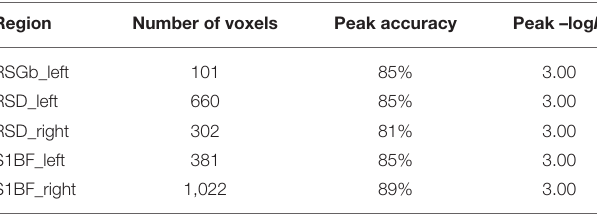
TABLE 2 | The top regions that contributed to kindling-control classification (SVM) based on GMV maps. Region Number of voxels Peak accuracy Peak –log